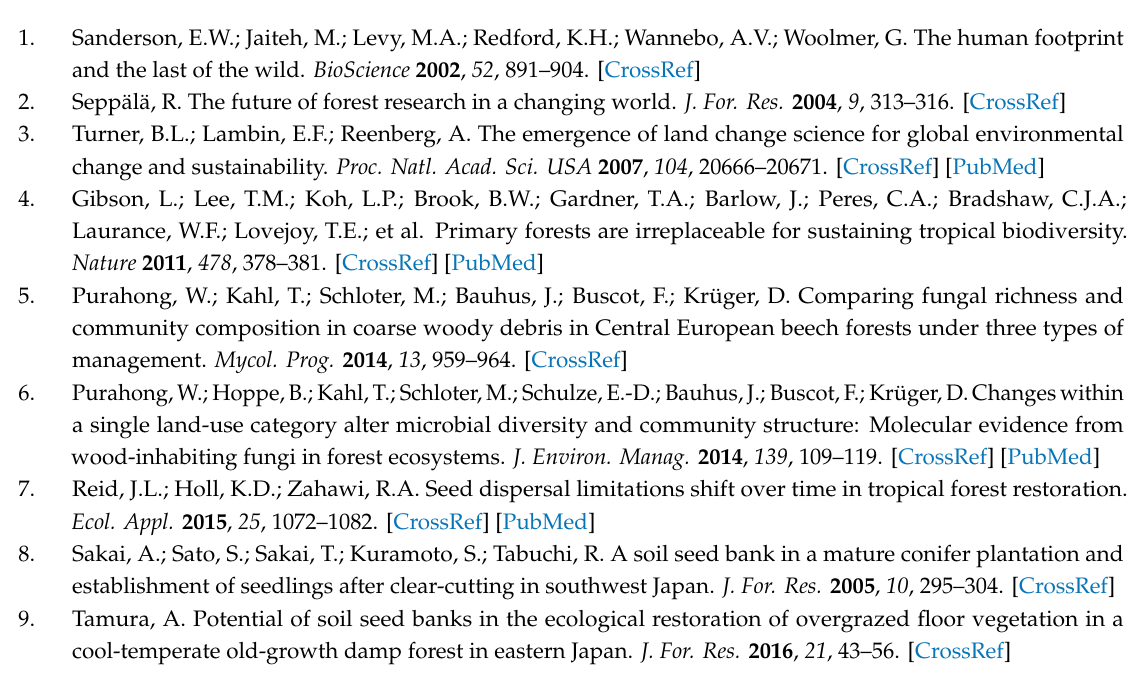
Figure S1 : Abundances of seeds from 16 plant species detected in this experiment; Table S1 : Abundances of seeds from 16 plant species detected in the seed trap at di ff erent locations; Table S2 : Abundances of seedlings from 35 plant species detected in the soil seed bank; Table S3 : Plant abundances and species richness detected in the soil seed bank experiment; Table S4 : Correlations among di ff erent factors tested in this study; Table S5 : Partial correlations between mortality rate and air temperature; Table S6: Partial correlations between mortality rate and relative humidity; Table S7: Comparisons of the number of tree species detected in the tree canopy (forest stand) and corresponding number of tree species detected in the seed rain / soils seed bank / seedling (and the percentage compared to the canopy) across di ff erent tropical forests; and Table S8 : Light intensity measured in this study during May 2004 to January